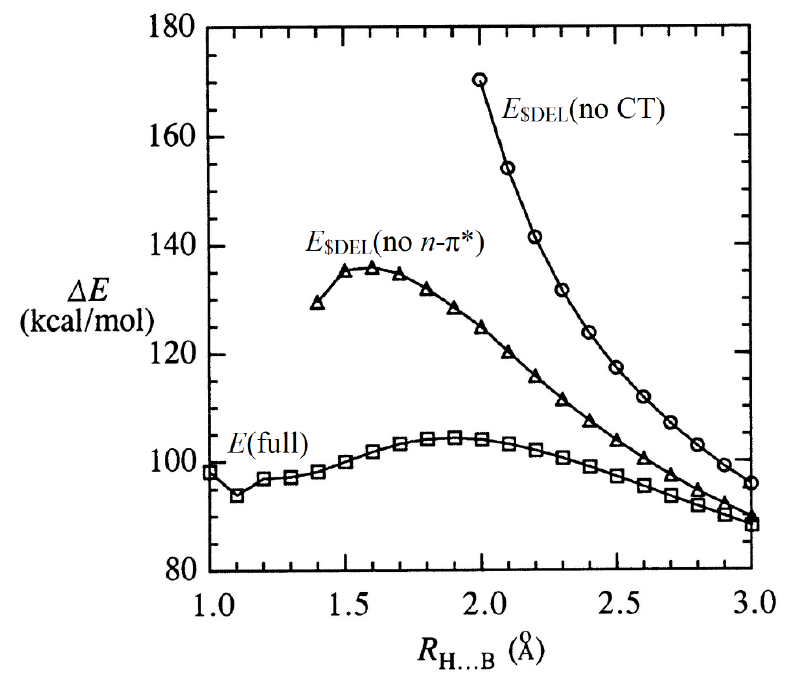
Figure 6. Relaxed-scan H − ···BO − interaction energy Δ E (relative to isolated H − + BO − ; cf. right-axis scale of upper-left panel in Figure 3), showing the strong deviations from the full calculation (squares) with respect to corresponding $DEL-type 23 variational reoptimizations that “delete” either the single in-plane NBO n H - π * BO matrix element (triangles) or all intermolecular NBO donor-acceptor interactions (circles).